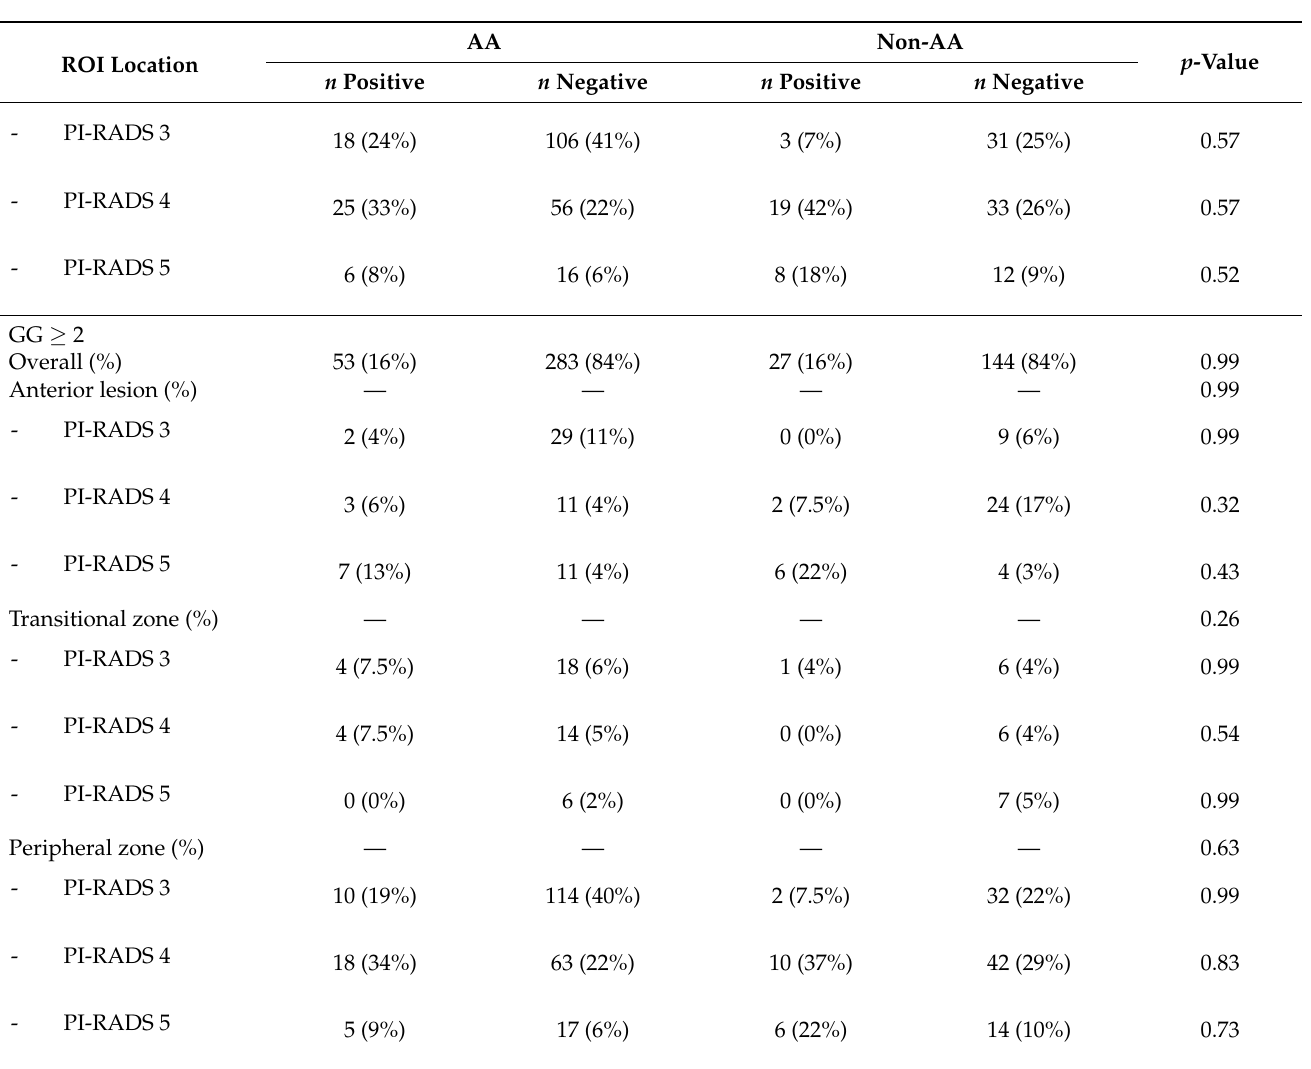
the curve (AUC) for locating cancer when compared to PIRADS 2/3 ROIs ( p < 0.0001). ROC curved were then used to compare AUC between our racial groups (Figure 2B).